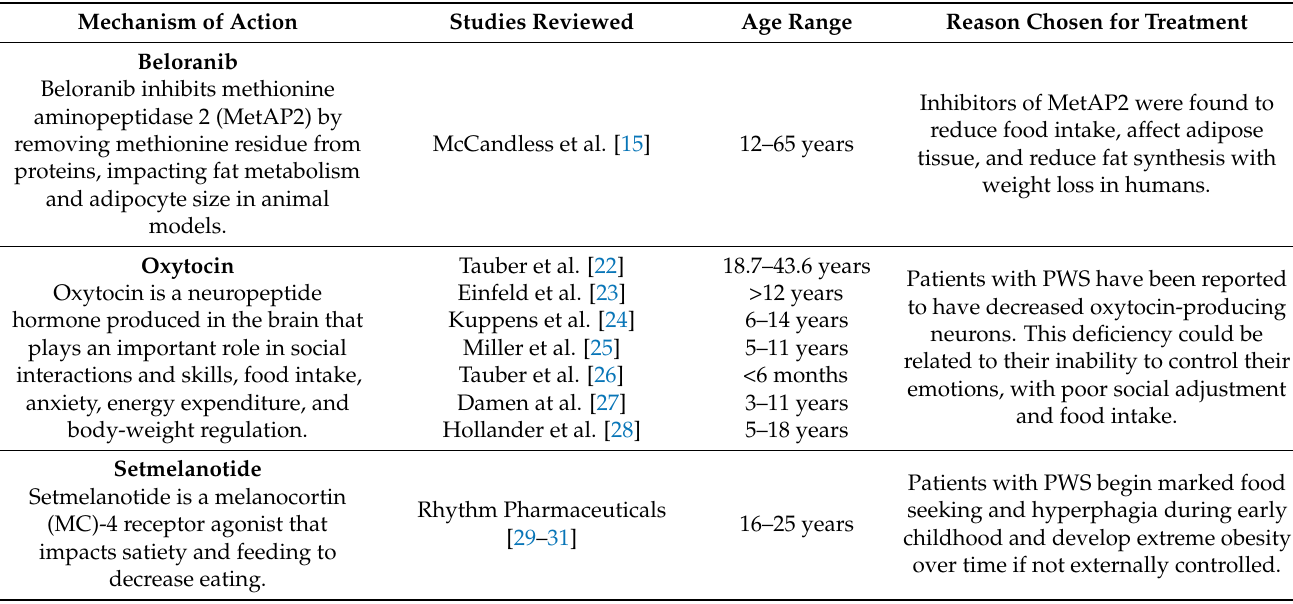
Table 1. Summary of drugs and medical devices used in PWS clinical